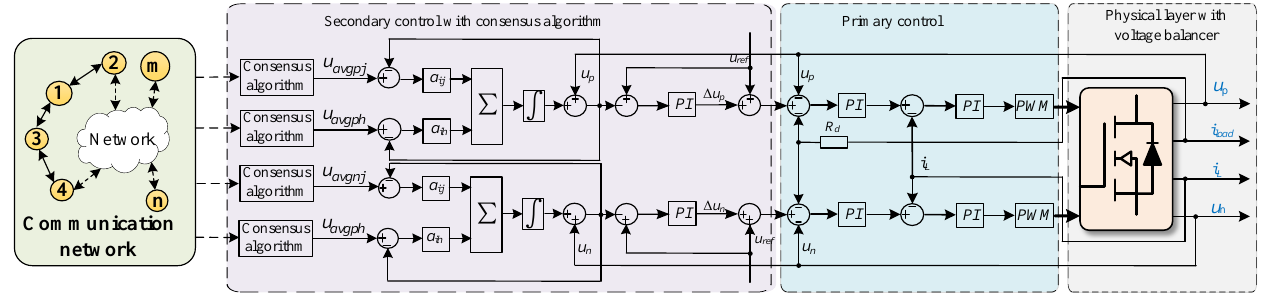
duty cycles D 1 = D 2 = 0.5.